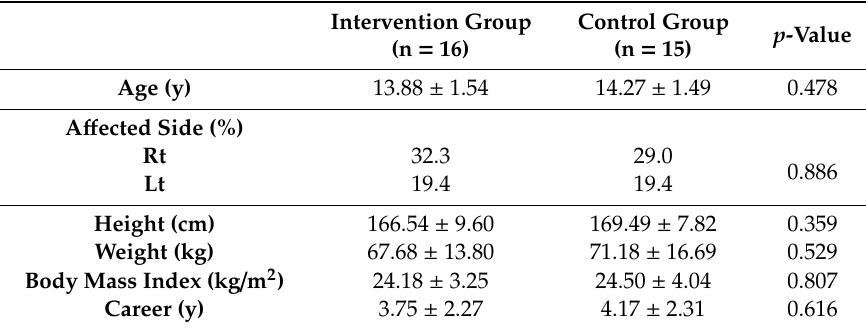
Table 1. General characteristics of the